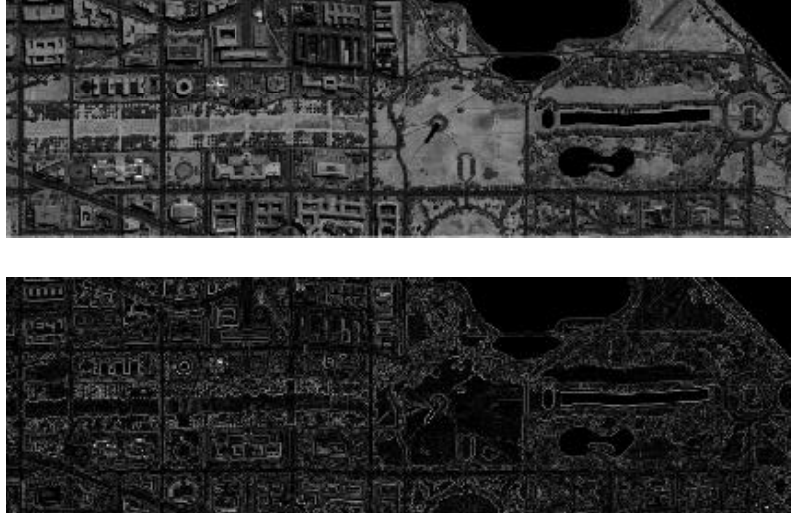
Figure 2. Visual exhibition of the 70th band of the Washington DC Mall and its corresponding gradient